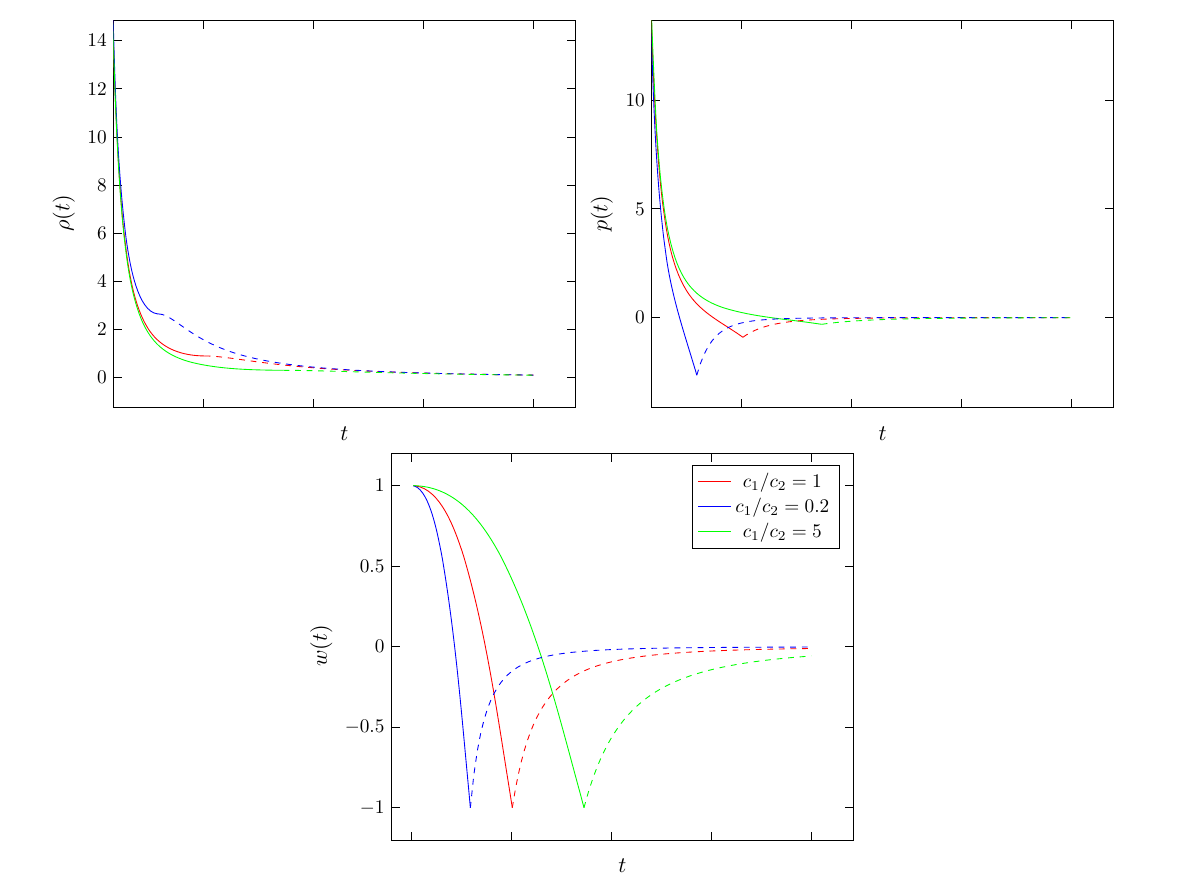
Fig. 2 Density ρ( t ) , pressure p ( t ) and the parameter w = p /ρ as the functions of time for three values c 1 / c